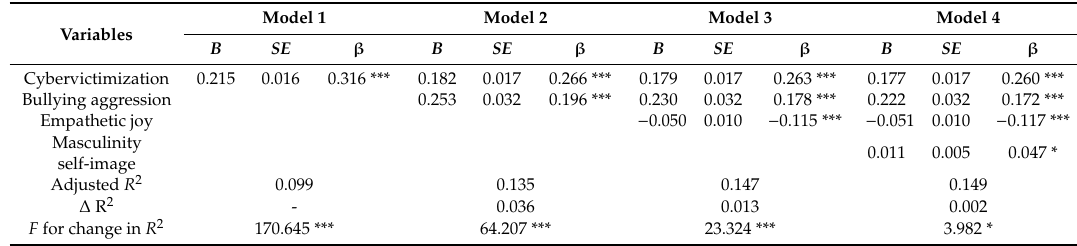
Table 3. Predictor variables of cyberaggression for the whole